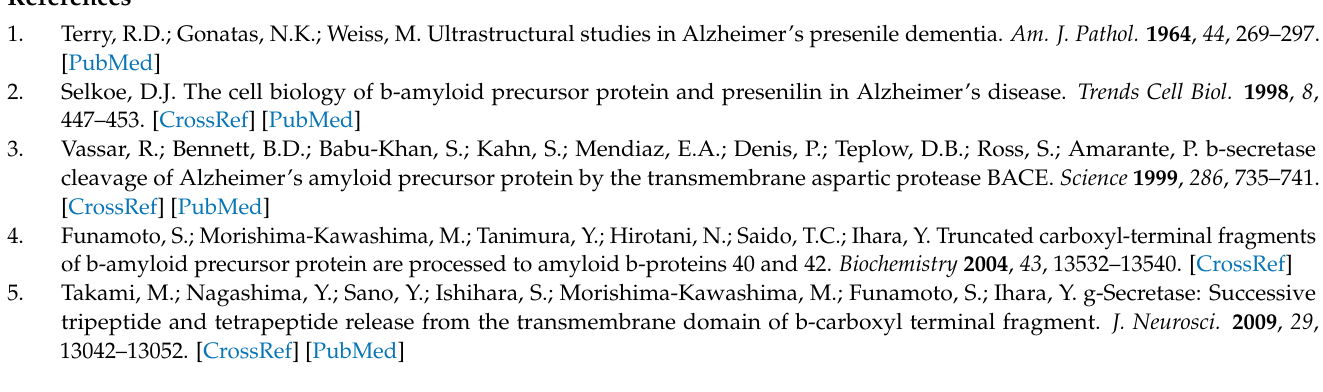
Figure 6. Amyloid-β neuronal damage and TREM2-mediated activation of microglia [43]. Amyloid- β deposition can disrupt the neuronal membrane and attract microglia, partly through TREM2 signaling, which, in healthy conditions, should repair or remove damaged membranes. When this process fails or is overwhelmed, tangle formation is instigated. The pink oval highlighting represents disruption of the membrane by the amyloid-β stubs. Contact charts for previous models. Figure S2: 2D NMR figures not previously published or in Main Text Figure 1. The short-mixing 2D DARR spectrum of each sample, showing only intra-residue cross-peaks, is on the left part of each panel. The long-mixing 2D DARR spectrum that provides inter-residue contacts is on the right part. (A) sample A, (B) sample B, (C) sample C. Figure S3: Detailed depictions of N-strand and C-strand beta-sheet models. Figure S4: SEC peak vs. TEM im- ages (perhaps also particle size estimates). Figure S5: fibrils in cryo-EM samples. Figure S6: more representations of the 150 kDa structural model. Figure S7: PITHIRDS-CT simulations showing that data can accommodate Carulla-like registry shorts in the C-strand alignment. Table S1: List of 150 kDa oligomer samples analyzed by solid-state NMR. The samples differ in isotope-labeling scheme and sample preparation method. NMR spectra for lyophilized samples were presented in our pre- vious work. Centrifuged samples were analyzed for the first time in the present work. Table S2: NMR chemical shifts (ppm)/linewidths (full width half maximum, ppm) for all 13 C-labeled sites in the Aβ(1–42) 150 kDa oligomer samples A, B, and C. The carbons in each amino are labeled as they are in the Biological Magnetic Resonance Data Bank. Estimated error is ±0.1 ppm for both the chem- ical shift and line width unless specified otherwise. Table S3: Estimation of the particle sizes (based on diameters) of oligomers in different SEC fraction (Figure S4).